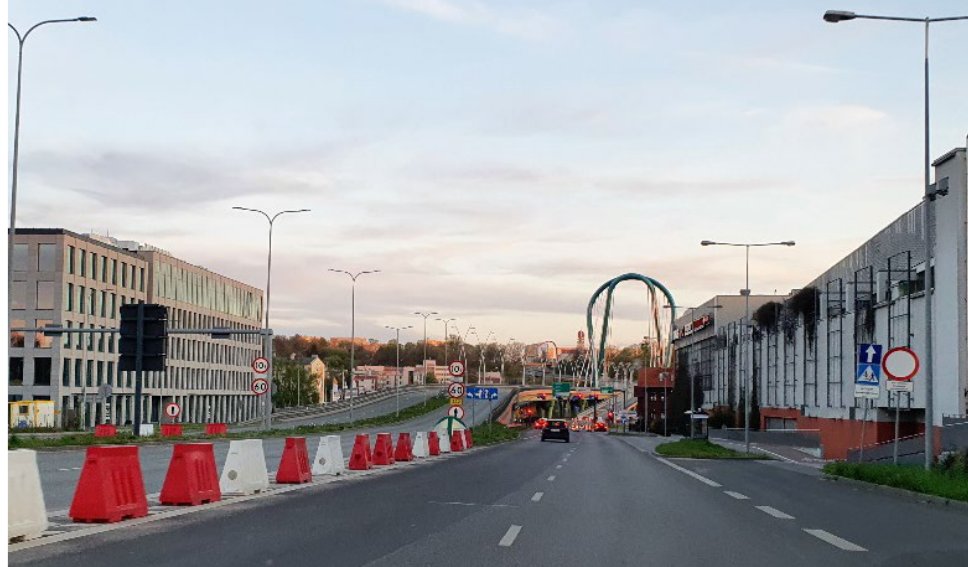
Figure 2. Traffic restrictions on the route (photo: 9 May 2021).